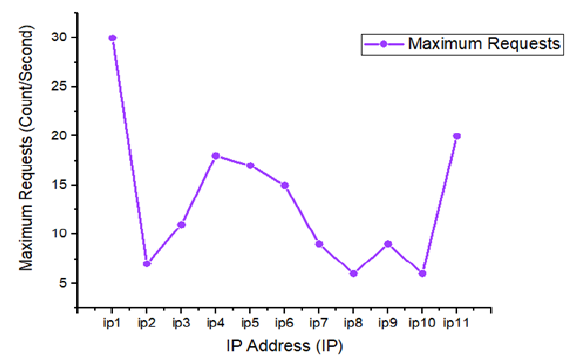
Fig 4: Request frequency 9 AM to 10 AM